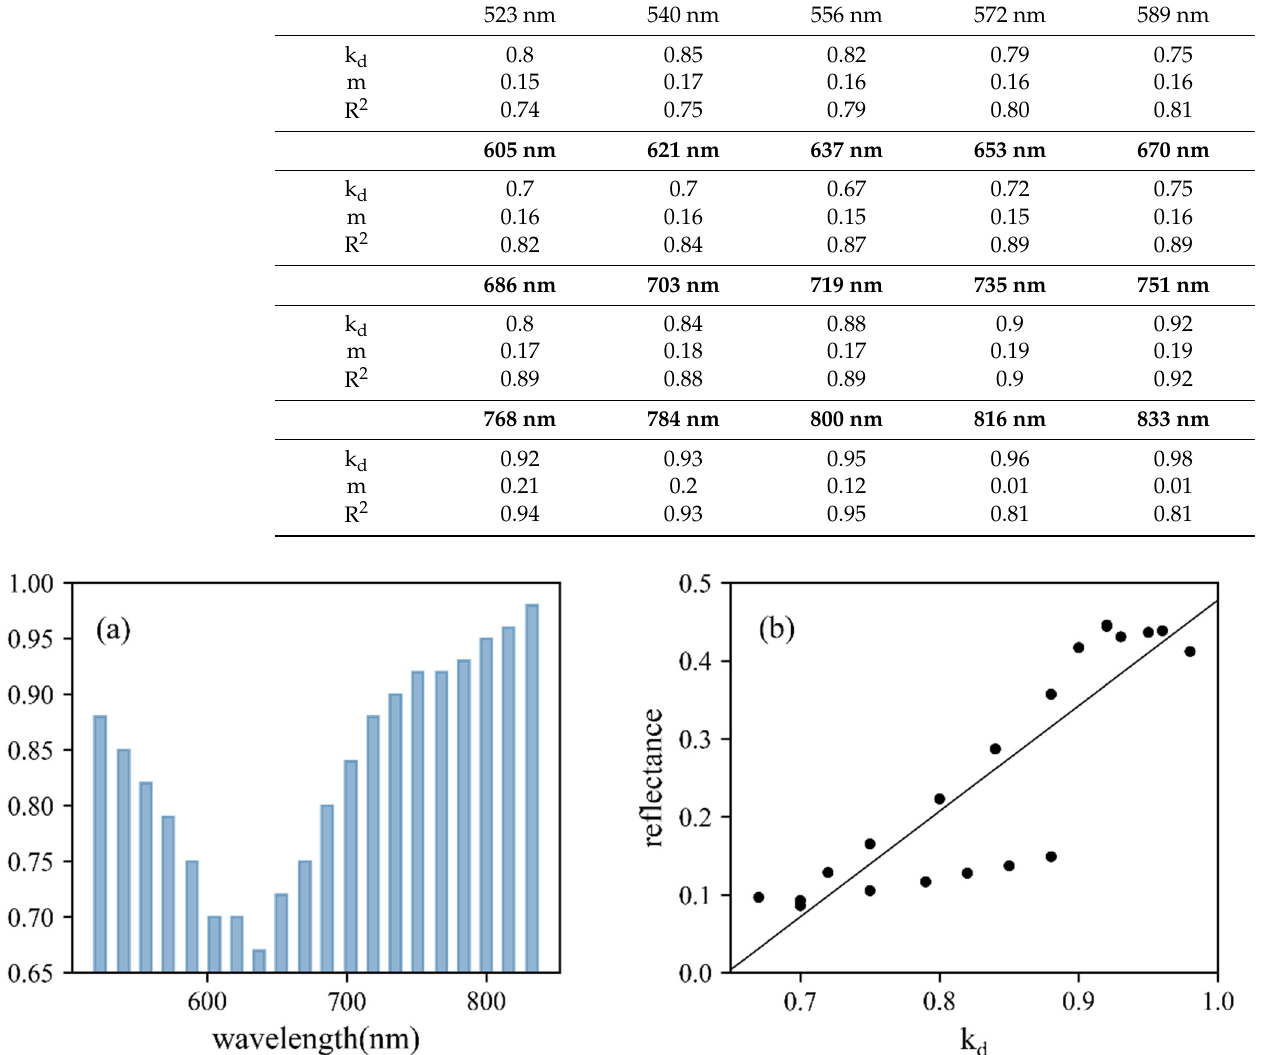
Figure 10. The 3D distribution of ( a , b ) elevation and ( c , d ) V cmax of two potted maize plants. The units of elevation and V cmax were cm and μ mol mol − 1 s − 1 , respectively. V cmax values were estimated using the constructed PLSR model of the reflectance- based method. The unit of X, Y, and Z was centimeter. 4. Discussion Previous studies have tested the ability of passive optical sensors in plant photosyn- thesis traits estimation [8,19,22], while these remote sensors were easily affected by some confounding factors (e.g., illuminating conditions, plant structure, and soil background) and had a weak ability in detecting plant structural parameters, limiting their further